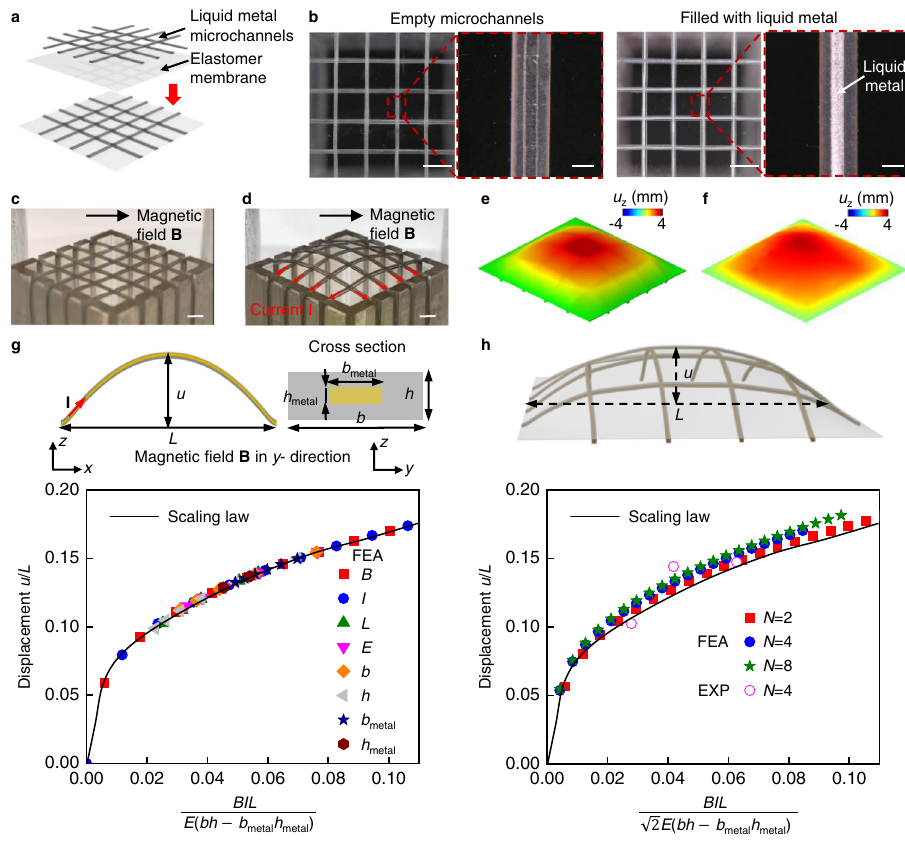
Fig. 1 Programmable surfaces enabled by electromagnetic actuation of liquid metal networks. a Schematic illustration of the fabrication process. Soft micro fl uidic channels fi lled with liquid metal serve as conducting ribbons bonded onto a thin elastomeric membrane (~5 µ m) to form the programmable surface. b Optical image of the programmable surface before and after fi lling with liquid metal. The elastomeric membrane is optically transparent in regions not occupied by liquid metal. Scale bar, 5 mm for the surface, 500 µ m for the exploded view illustration of the microchannels. Optical images of the surface in the initial fl at con fi guration ( c ) and at maximum deformation ( d ). Various 3D shapes can be obtained through the action of Lorentz forces by controlling the electric currents passing through each liquid metal ribbon. Scale bar, 5 mm. FEA ( e ) and 3D Digital Image Correlation (3D-DIC; f ) results of the surface in d . g Scaling law results for the maximum deformation of an isolated liquid metal ribbon as a function of ribbon geometries, material properties, magnetic fi eld strength, and applied current. h Plots of the maximum surface deformation as a function of the scaling law parameters with different ribbon numbers (2-by-2, 4-by-4, and